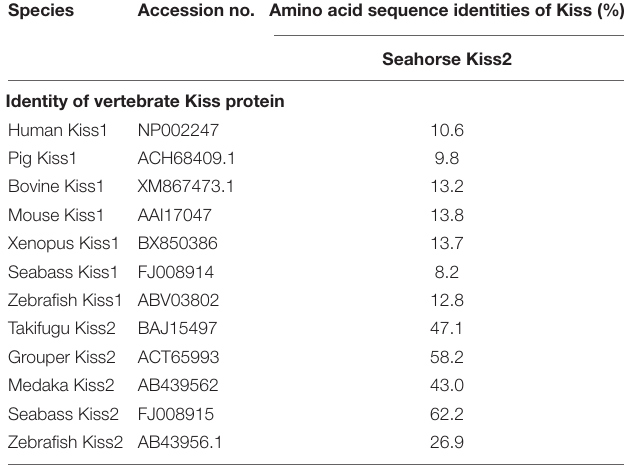
TABLE 2 | Amino acid sequence identities of the lined seahorse kiss2 with kiss genes of various vertebrates.